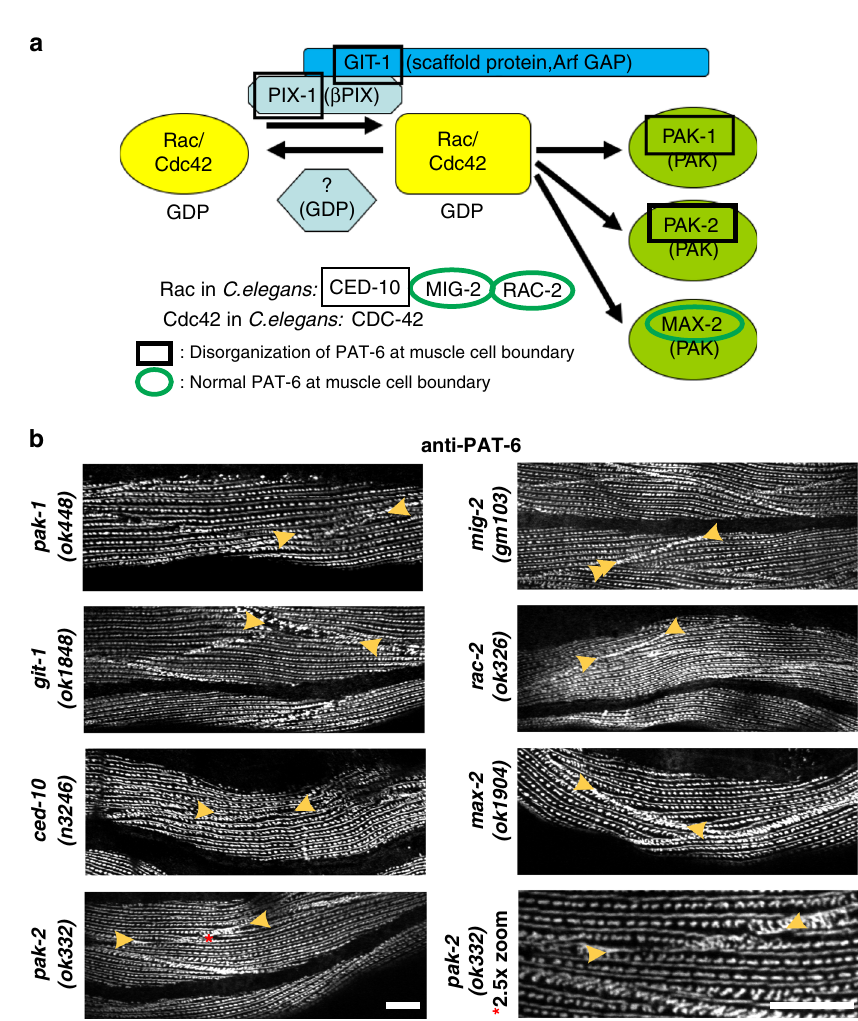
Fig. 7 Mutations in genes encoding known proteins of a PIX-1 pathway result in muscle cell boundary disruption. a Putative PIX-1 biochemical pathway based on what is known of PIX proteins in mammals and other cell types in C. elegans . Also indicated is a summary of the results shown in b . b Confocal images of body wall muscle from the indicated mutants immunostained with anti-PAT-6. Note reduced or disorganized PAT-6 localization at muscle cell boundaries (indicated by arrowheads) in pak-1 , git-1 , ced-10, and pak-2 mutants, but normal PAT-6 localization in mig-2 , rac-2, and max-2 mutants. A higher magni fi cation view (bottom row, right) of pak-2(ok332) is shown because it has a more subtle defect than the other mutants. Results on second alleles for rac-2 and ced-10 are shown in Supplementary Fig 3. Each image is a representative image obtained from at least 2 fi xation and immunostaining experiments, and imaging at least three different animals of each strain. Scale bar, 10 μ